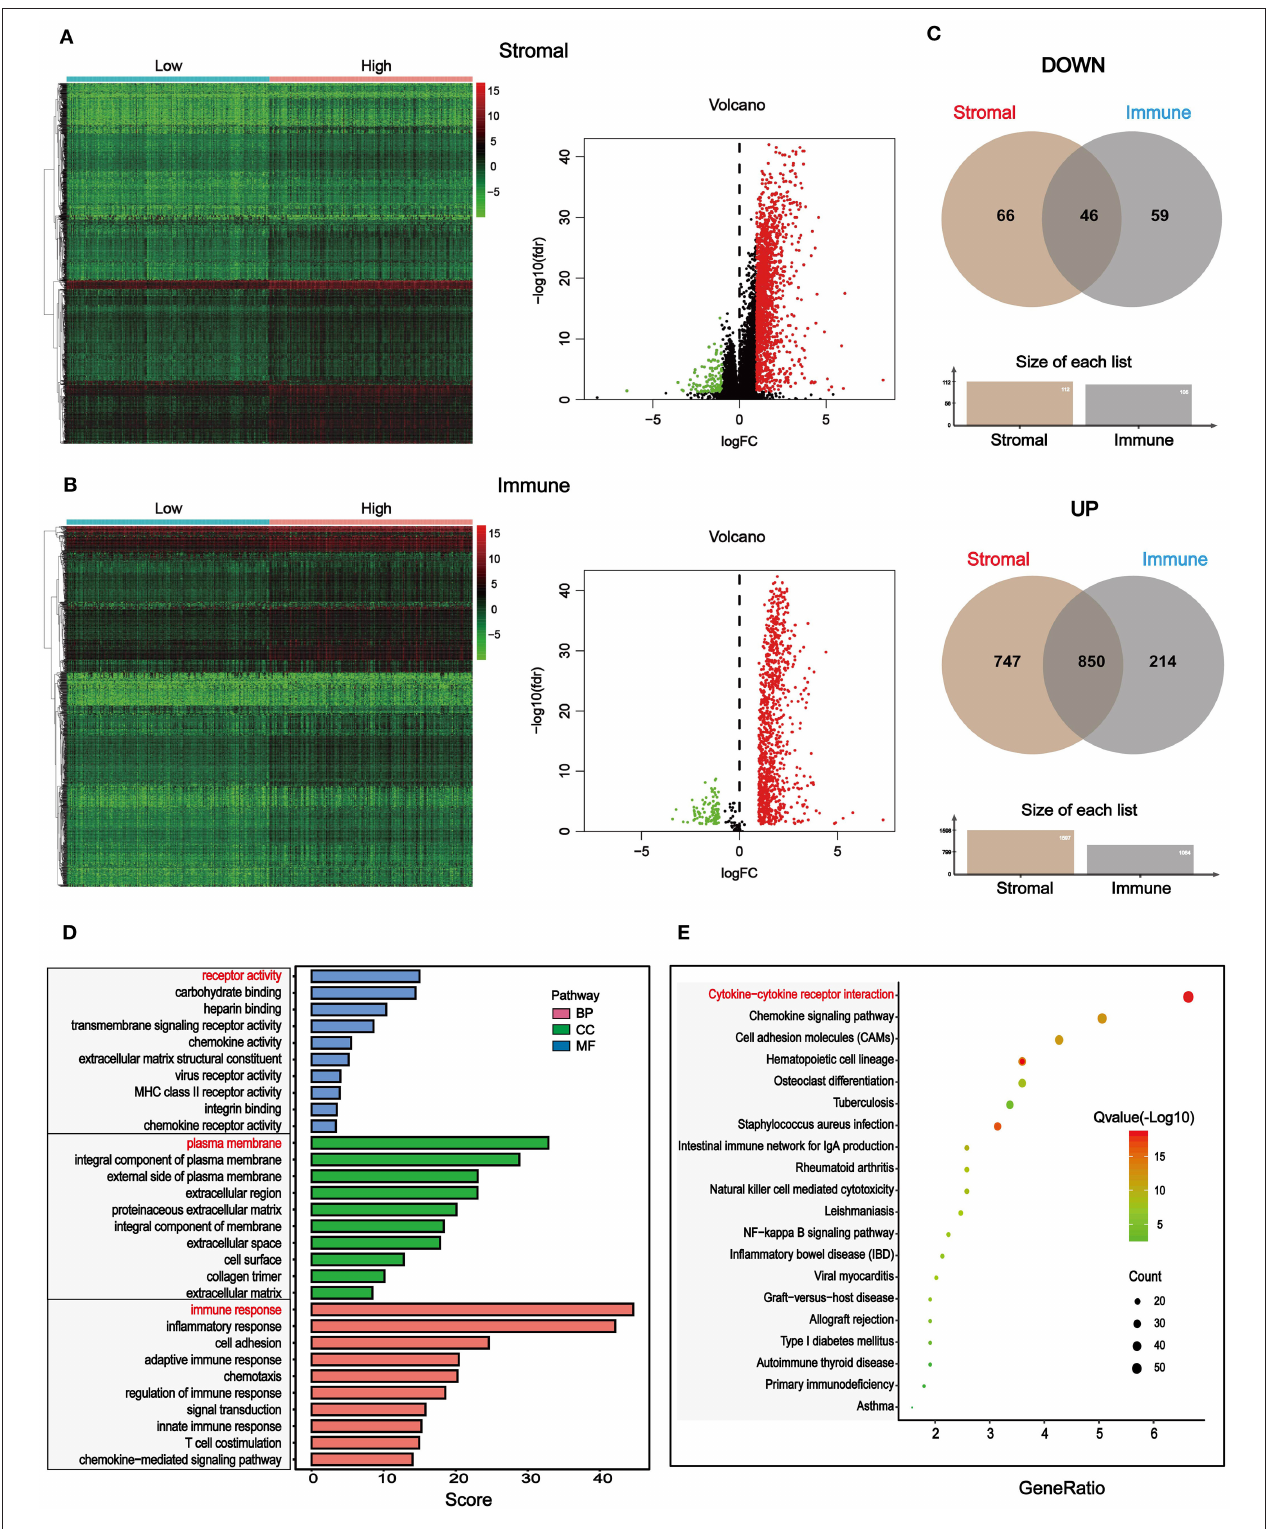
FIGURE 2 | Differentially expressed genes (DEGs) based on immune and stromal scores of tumor microenvironment (TME) and their functional annotations in HCC. (A) Heatmaps and volcano plot of the DEGs of stromal scores ( p < 0.05, fold change > | ± 1|). (B) Heatmaps and volcano plot of the DEGs of immune scores ( p < 0.5,